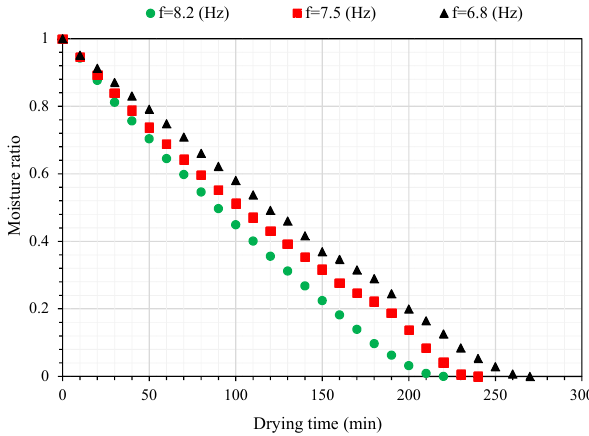
Fig. 6. Moisture ratio versus drying time of hawthorn at different vibration intensity (drying air flow rate=26 m 3 /h and drying air temperature=50 o